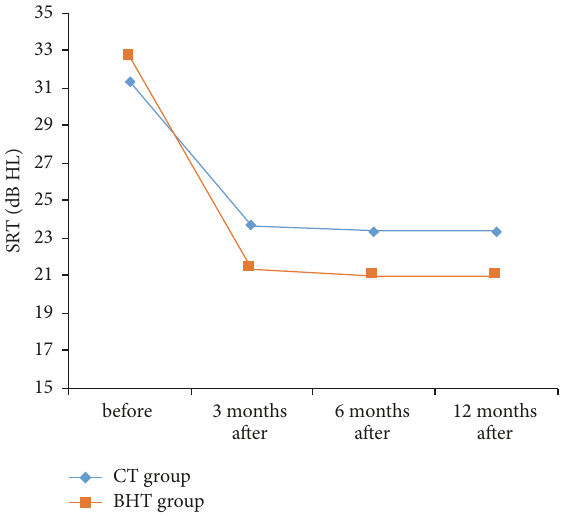
Figure 7: The trend of the change in SRT parameter in two groups.